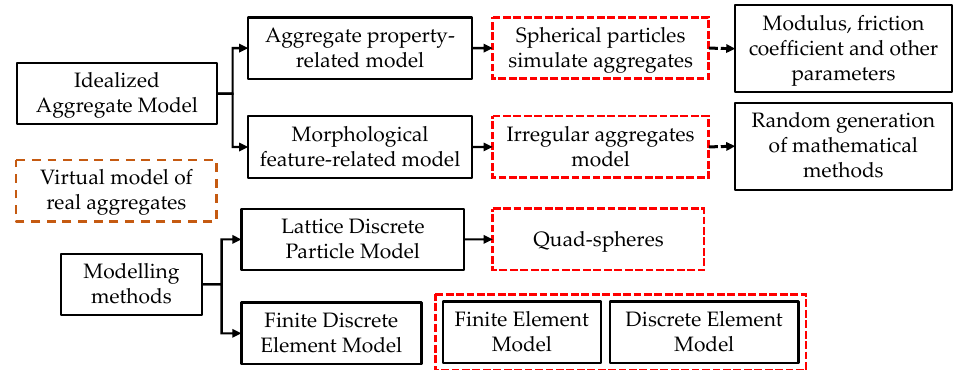
Figure 8. Categories of idealized model and modelling methods for aggregate.